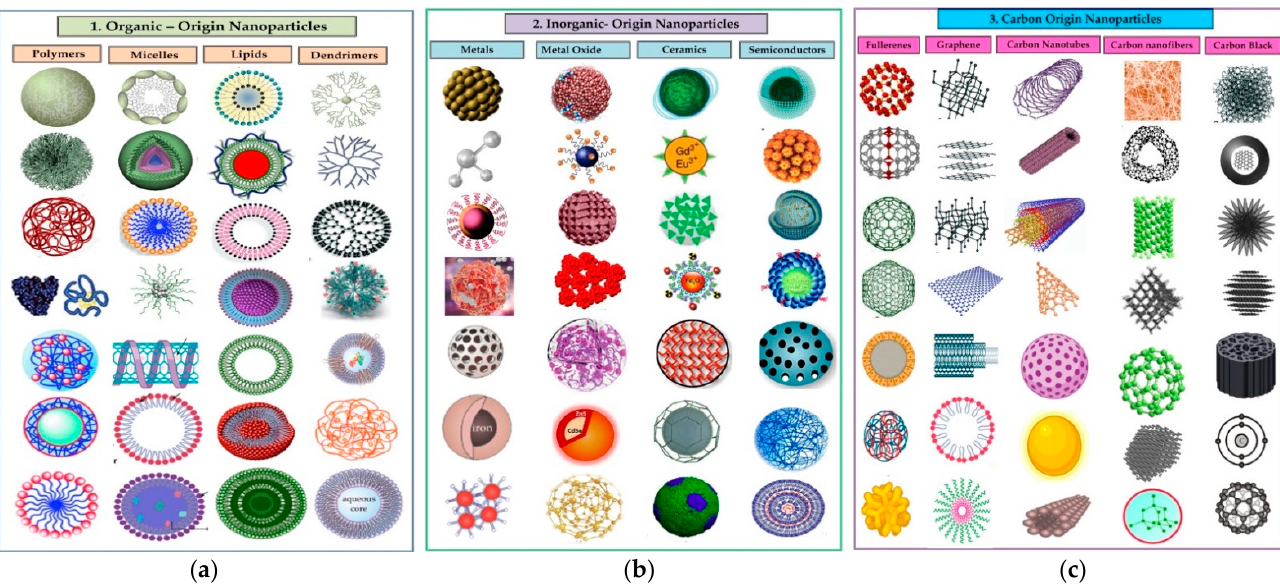
Figure 1. Classification of NPs: (1) organic-origin NPs, containing polymeric NPs and lipid-based NPs; (2) inorganic-origin NPs, containing metal NPs, metal oxide NPs, ceramic NPs, and semicon- ductor NPs; (3) carbon-origin NPs, containing fullerene NPs, graphene NPs, and carbon NPs (idea adapted from ref [45].